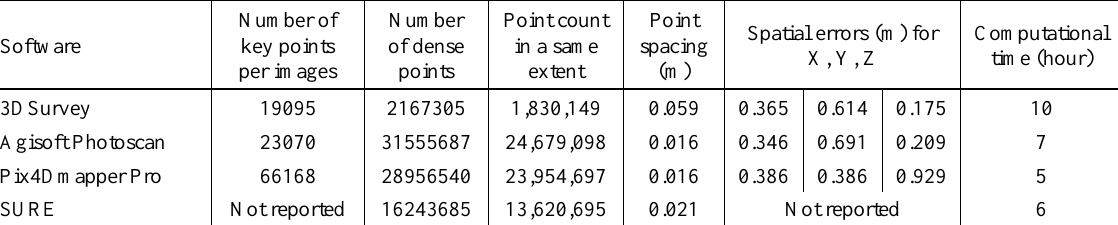
Table 1. Characteristics of generated point clouds by different